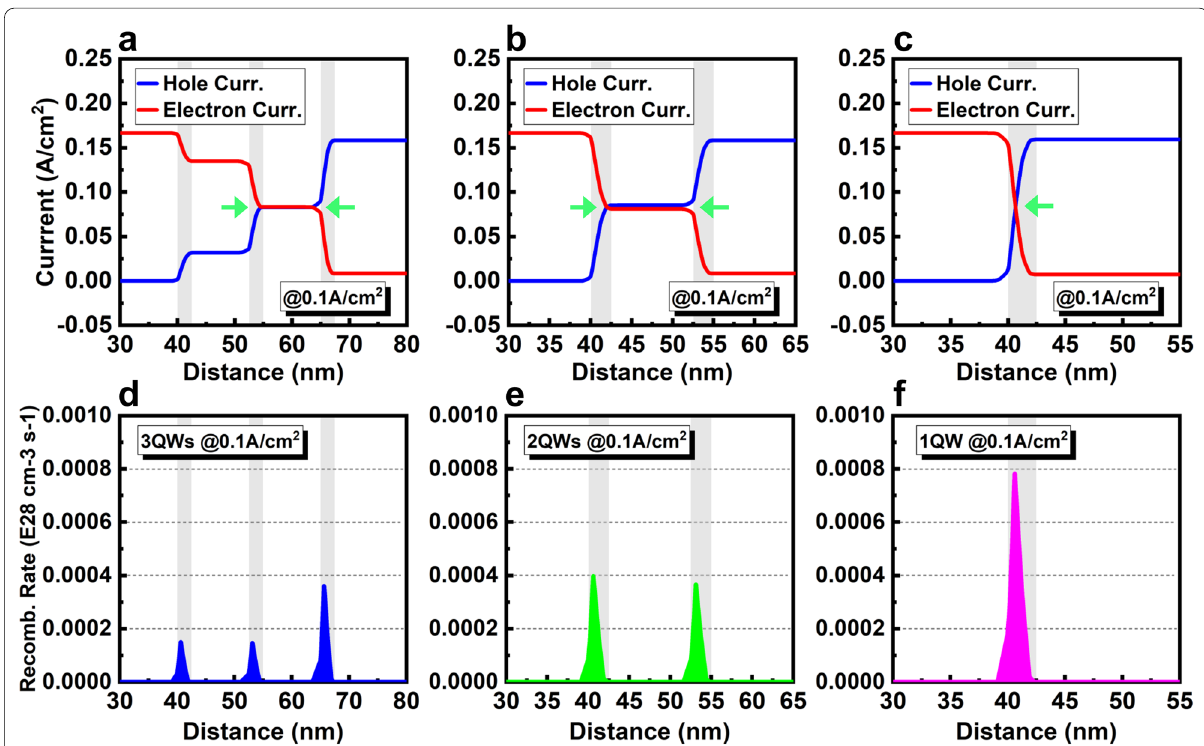
Fig. 4 Carrier current distribution of LED with a 3QWs, b 2QWs, and c 1QW at 0.1 A/cm 2 . Radiative recombination rates of LED with d 3QWs, e 2QWs, and f 1QW at 0.1 A/cm 2